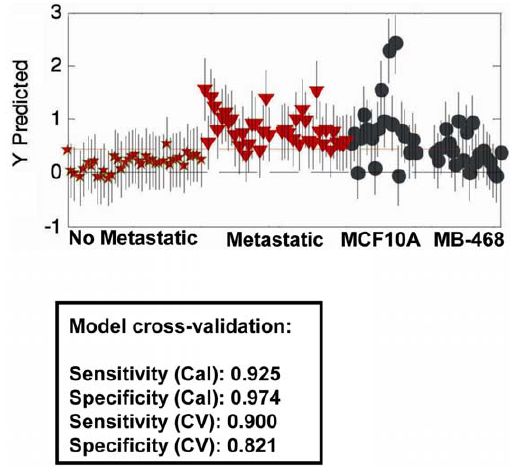
Figure 3. PLS-DA discriminative model using Raman micro- spectroscopy spectra of non-metastatic (SKBR3 and MCF7) and metastatic (MDA-MB-231 and MDA-MB-435) cell lines. PLSDA classification algorithm, in which non-metastatic cells are predicted with class 0 and metastatic cells with class 1. A threshold is assigned (red line) corresponding to the best specificity and sensitivity parameters that separate groups of cells. RMSECV is represented by the error bars. A sensitivity of 90% and a specificity of 82.1% were achieved. Once the model was built, MCF10A and MDA-MB-468 were included to predict their membership. Seventy-five per cent of MCF10A and 40% of MDA- MB-468 cells are related to the metastatic group.